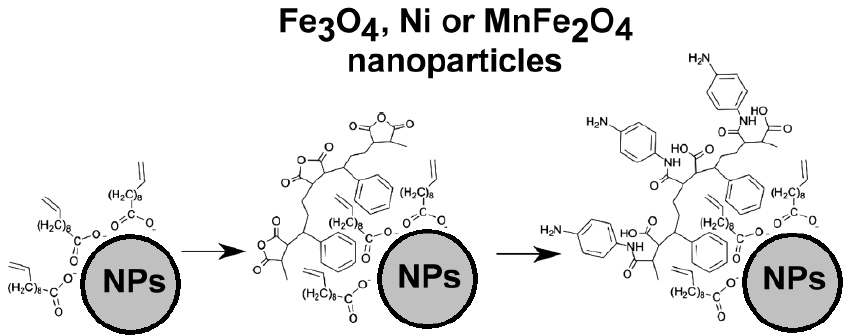
Figure 13. Coating of magnetic particles with polymers prior to incubation with